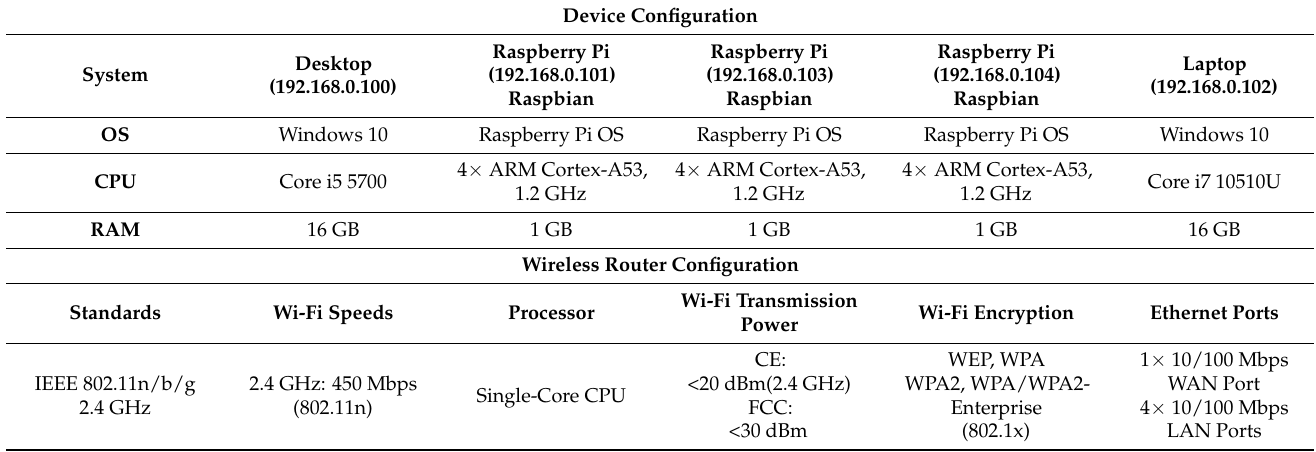
Table 1. Systems